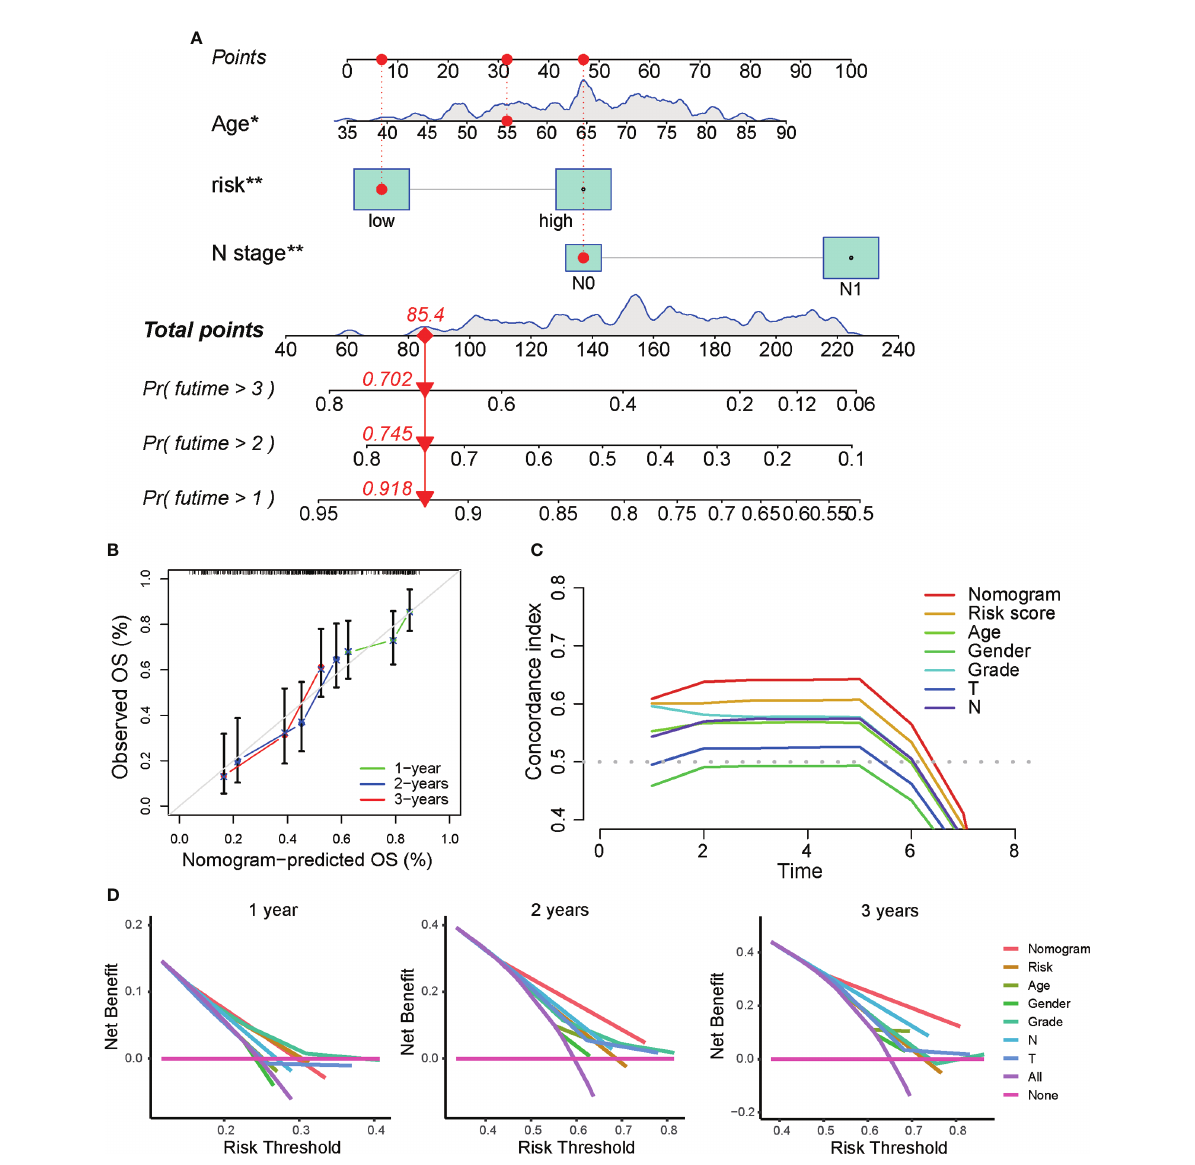
FIGURE 4 ConstructionofapredictivenomogrambasedontheDRGsignature. (A) Nomogrambasedontheprognosticsignatureconsistingofriskscoreandclinical factors. (B) Calibrationplotshowingthepredictiveaccuracyofthenomogramat1year,3years,and5years. (C) C-indexoftheprognosticnomograms, riskscore,andotherclinicalfactors. (D)